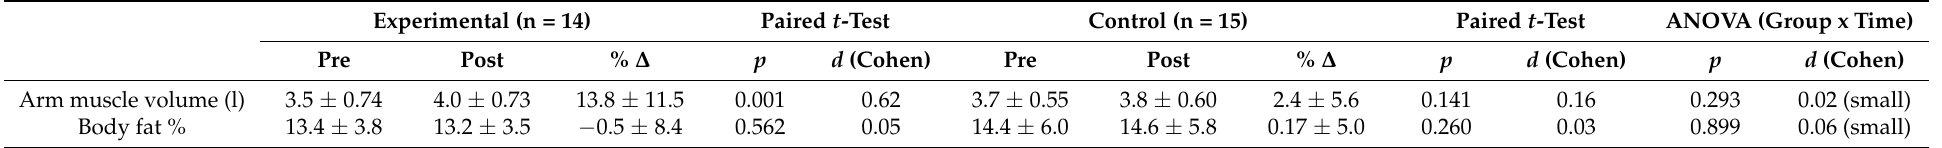
Table 3. Comparison of muscle volume of the arm and body fat percentage between the experimental and control groups before and after an 8 week intervention.